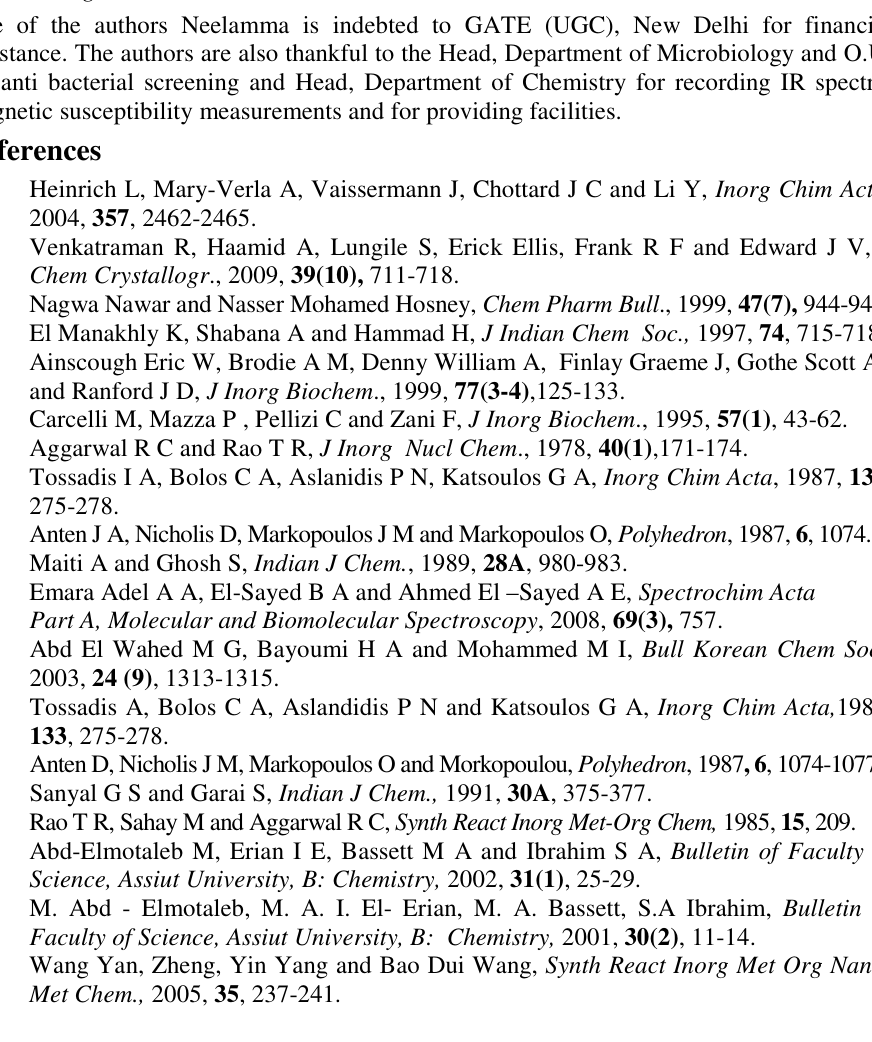
Figure 3 . Structure of metal complexes, where M=Cr(III) and Fe(III)